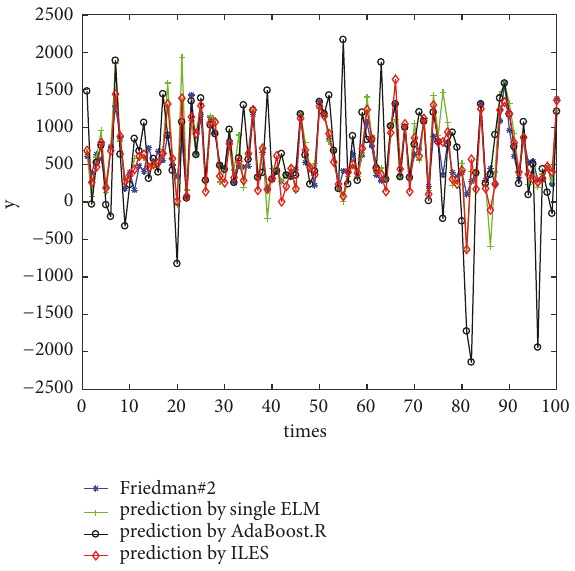
Figure 6: The comparison of Friedman#2 with different